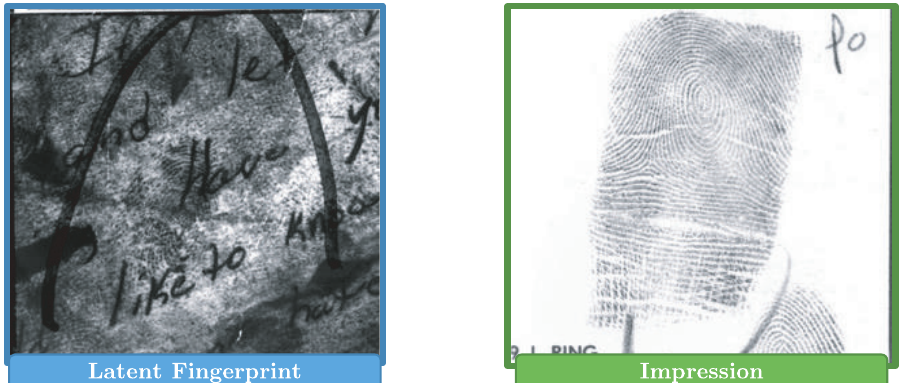
Figure 1. Example of a latent fingerprint and its corresponding impression, taken from the database NIST SD27 [23]. Notice how the latent fingerprint is a low-quality image, containing background noise that interrupts ridge flow. On the contrary, the impression is a clear and high-quality image taken under controlled